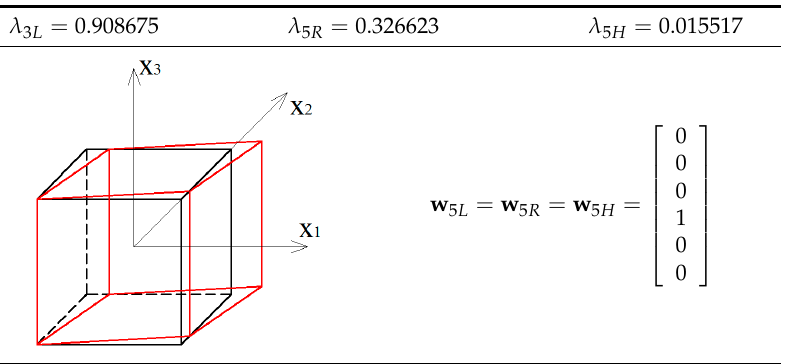
Table 5. Low shear mode of